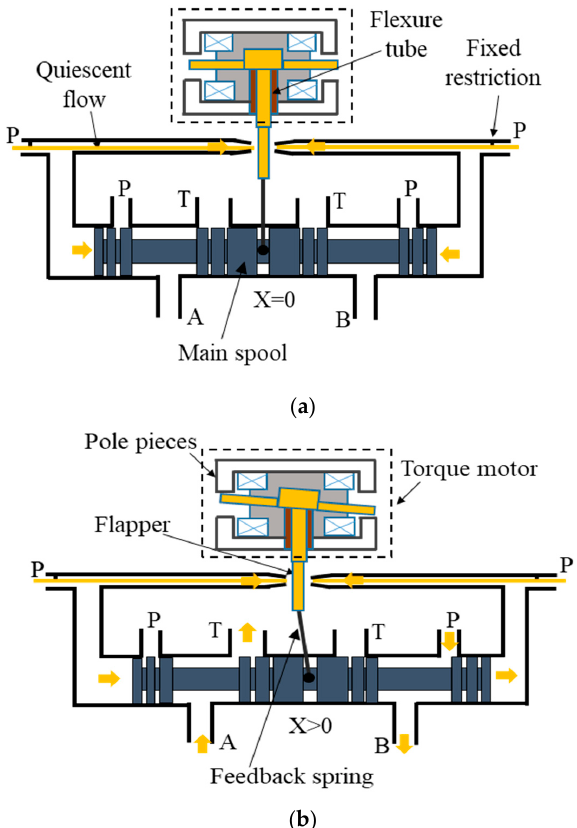
Figure 1. Operating principle of a double nozzle-flapper servovalve: spool not modulating flow ( a ) and flow modulation ( b ).